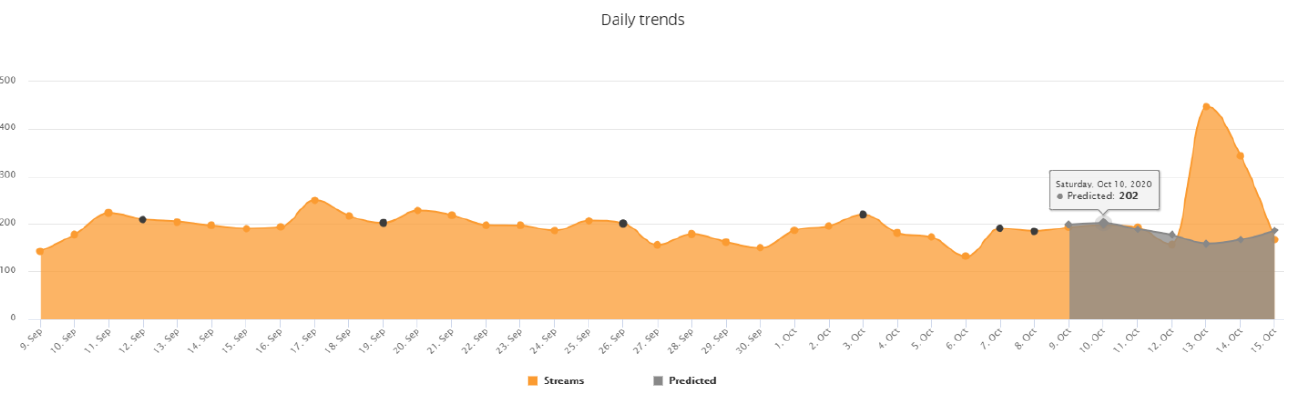
Figure 5. The presentation of outliers and explanations in DMGs monitoring system: Expected versus observed streaming count (Level 1 Explanation) are presented for each outlier and when the users hover the individual predictions the explanation of the predicted value is highlighted (Level 2